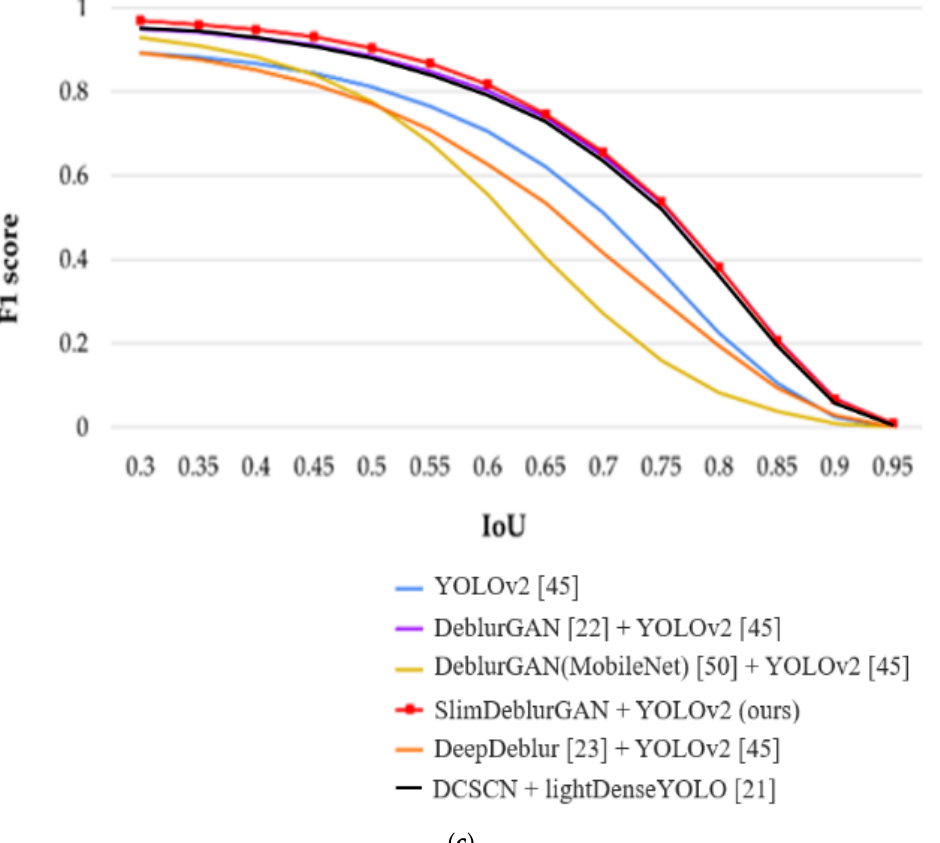
Figure 13. Marker detection results on SMBD-DB1 for the five methods at different IoU thresholds: ( a ) precision, ( b ) recall, and ( c ) F1 score.